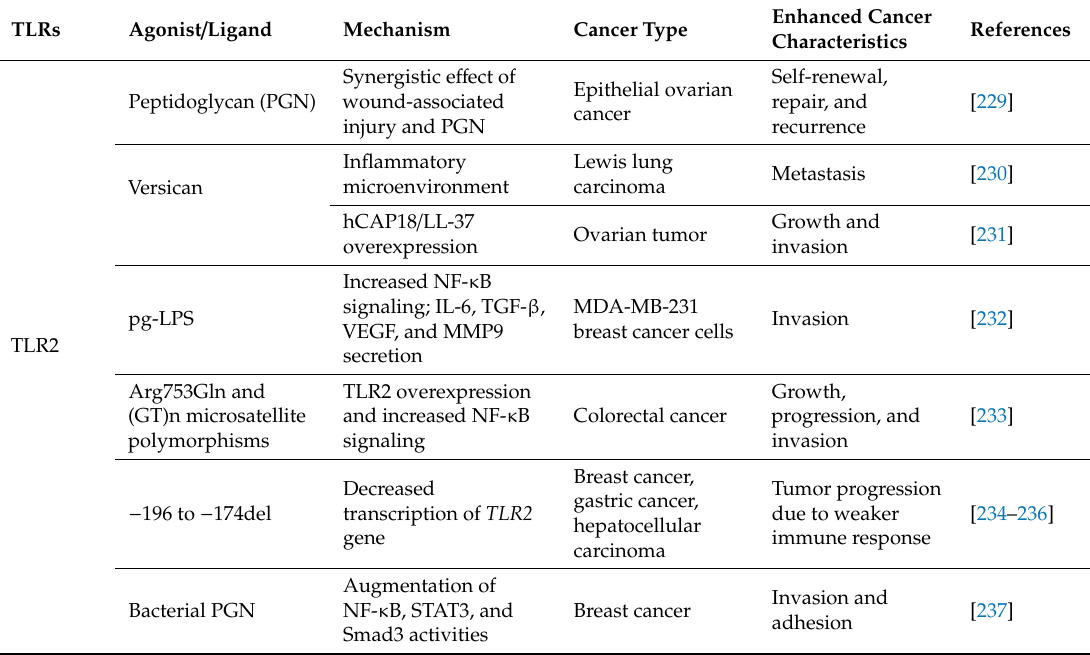
Table 1. TLRs with a protumor e ff